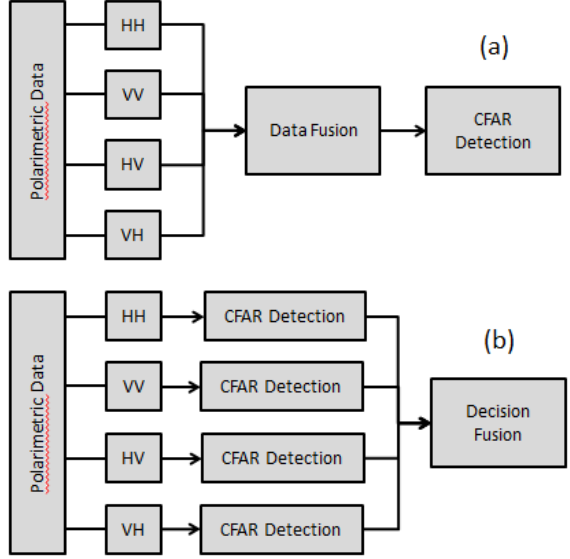
Figure 5. Polarimetric (a) data (top-diagram) and (b) decision (bottom-diagram) fusion